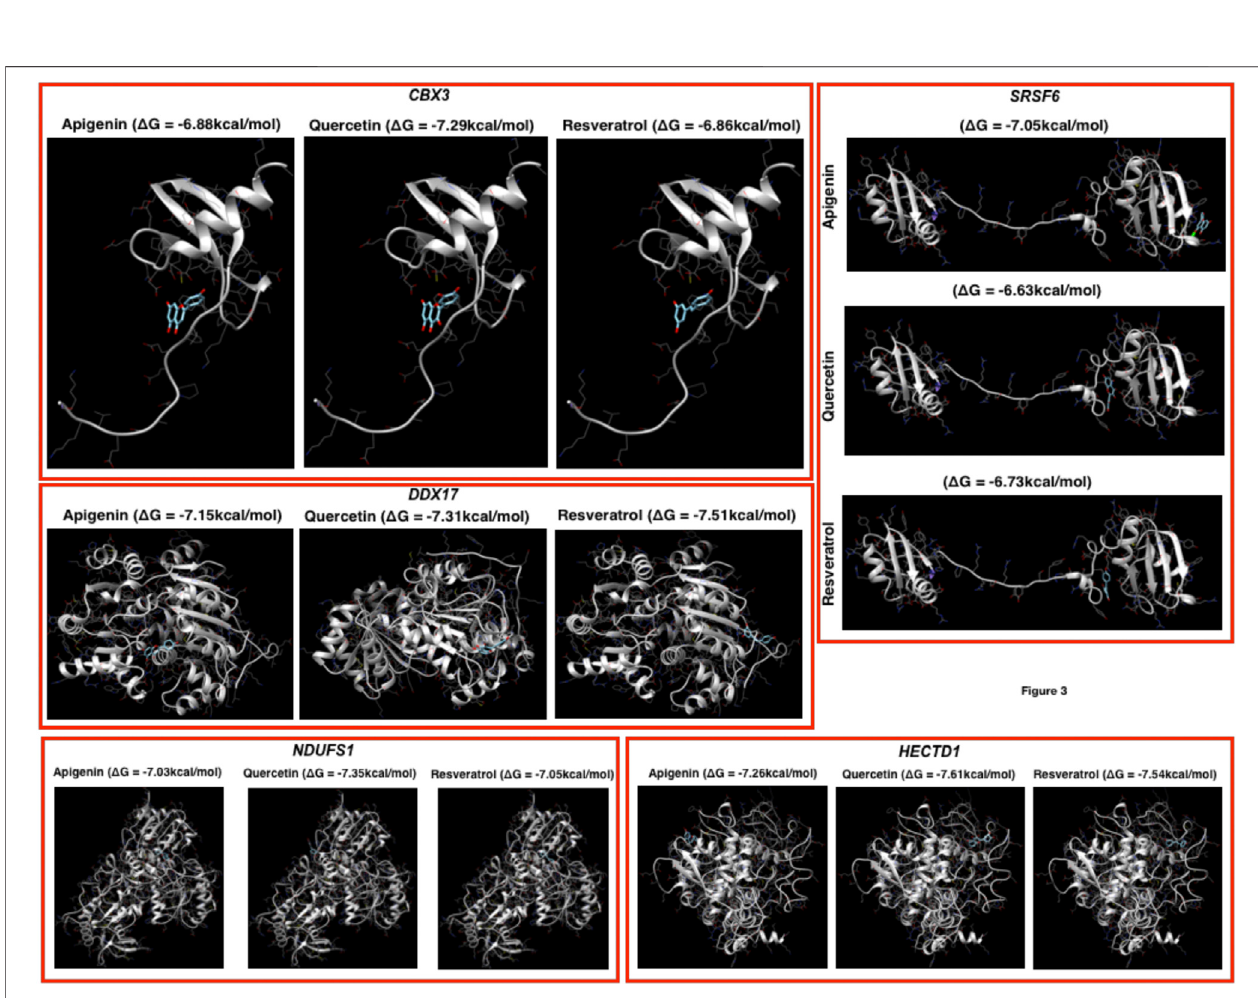
FIGURE 3 | Docking pro fi ling. Here, the docking has been performed by using the three herbal drugs (apigenin, quercetin, and resveratrol) against the top fi ve genes.